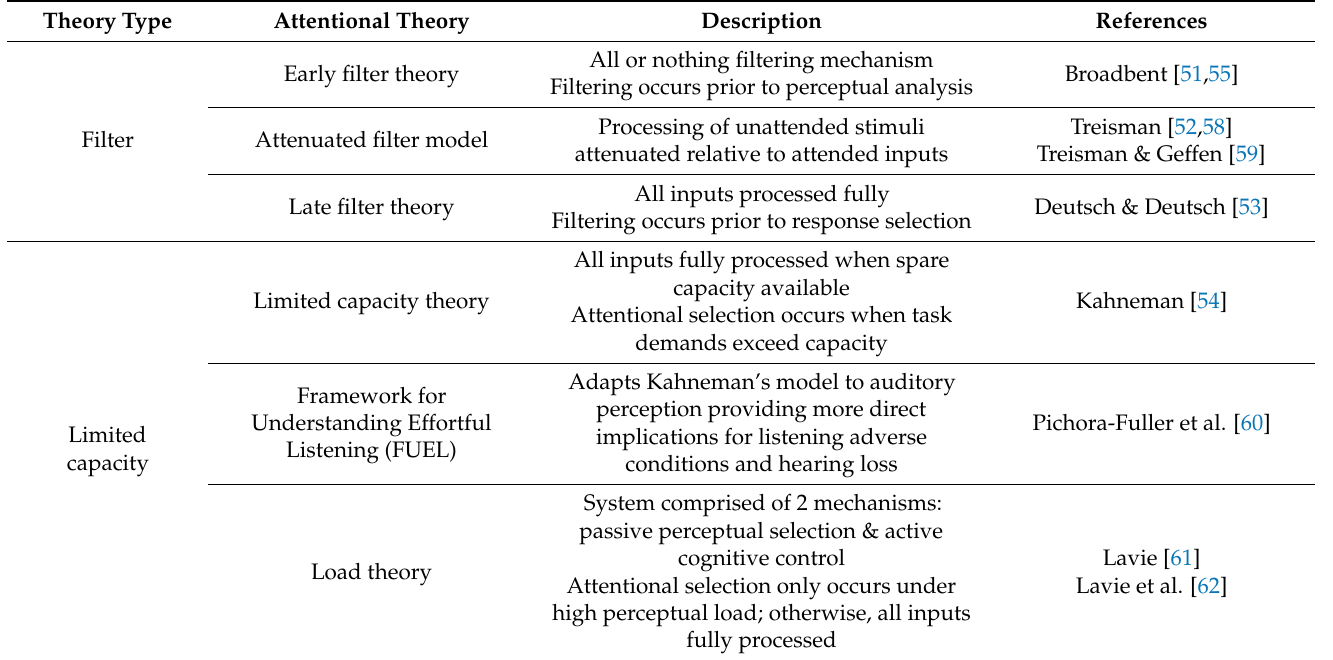
Table 1. Description of attentional